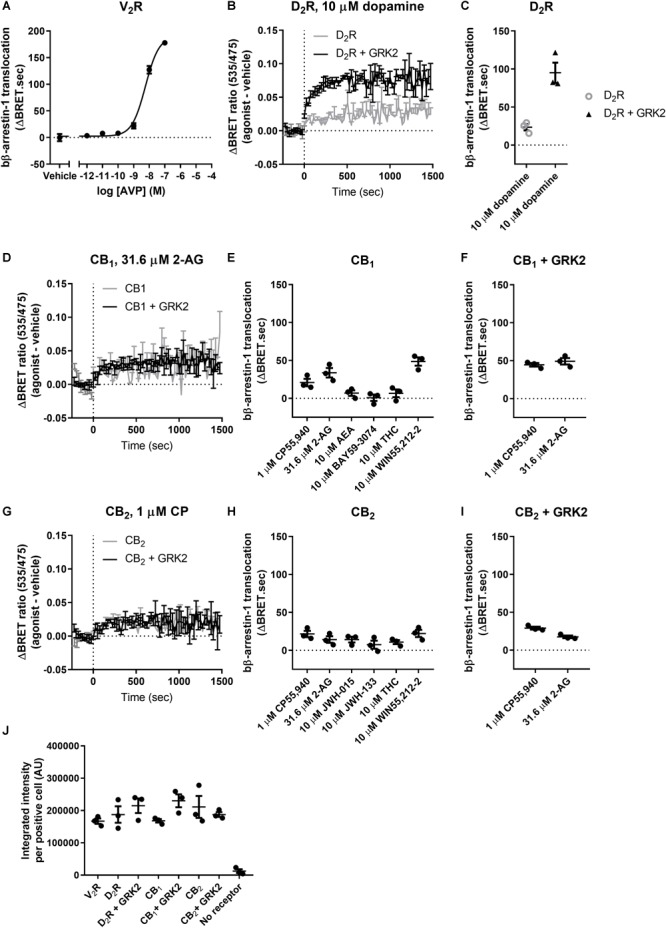
bβ-Arrestin-1 translocation to V2R, D2R, CB1, and CB2. (A) bβ-Arrestin-1 translocation to V2R stimulated with AVP. (B) ΔBRET ratio curves of bβ-arrestin-1 translocation to D2R with or without co-expressed GRK2 stimulated with 10 μM dopamine. (C) AUC quantification of translocation to D2R with or without co-expressed GRK2 stimulated with 10 μM dopamine as shown in (B). (D) ΔBRET ratio curves of bβ-arrestin-1 translocation to CB1 with or without co-expressed GRK2 stimulated with 31.6 μM 2-AG. (E) AUC of bβ-arrestin-1 translocation to CB1 stimulated with 1 μM CP55,940, 31.6 μM 2-AG, 10 μM AEA, 10 μM BAY, 10 μM THC, and 10 μM WIN55,212-2. (F) AUC of bβ-arrestin-1 translocation to CB1 with co-expressed GRK2 stimulated with 1 μM CP55,940 and 31.6 μM 2-AG. (G) ΔBRET ratio curves of bβ-arrestin-1 translocation to CB2 with or without co-expressed GRK2 stimulated with 1 μM CP55,940. (H) AUC of bβ-arrestin-1 translocation to CB2 stimulated with 1 μM CP55,940, 31.6 μM 2-AG, 10 μM JWH-015, 10 μM JWH-133, 10 μM THC, and 10 μM WIN55,212-2. (I) AUC of bβ-arrestin-1 translocation to CB2 with co-expressed GRK2 stimulated with 1 μM CP55,940 and 31.6 μM 2-AG. (J) Receptor expression of V2R, D2R, D2R+GRK2, CB1, CB1+GRK2, CB2, and CB2+GRK2 in cells used in experiments (A–G). Receptor expression was quantified in cells positive for expression by ICC. Error bars represent ±standard deviation of representative data with three technical replicates (A, B, D, G) or standard error of the means from three independent biological replicates (C, E, F, H, I, J).